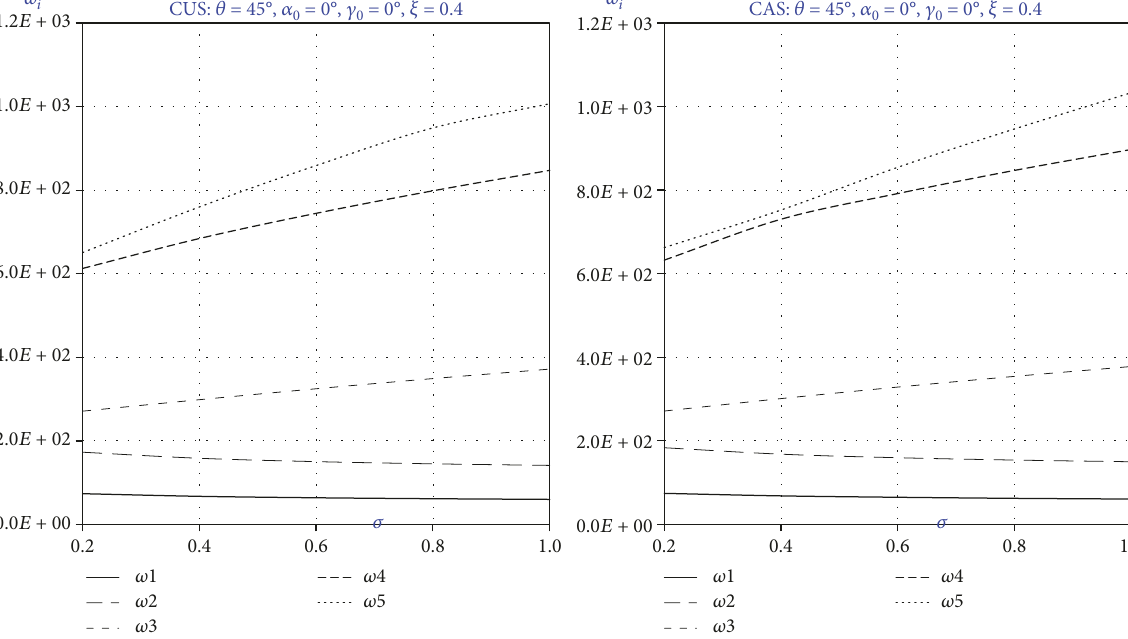
Figure 14: Eigenfrequencies vs. ply angle of Model A via σ for CUS and CAS.